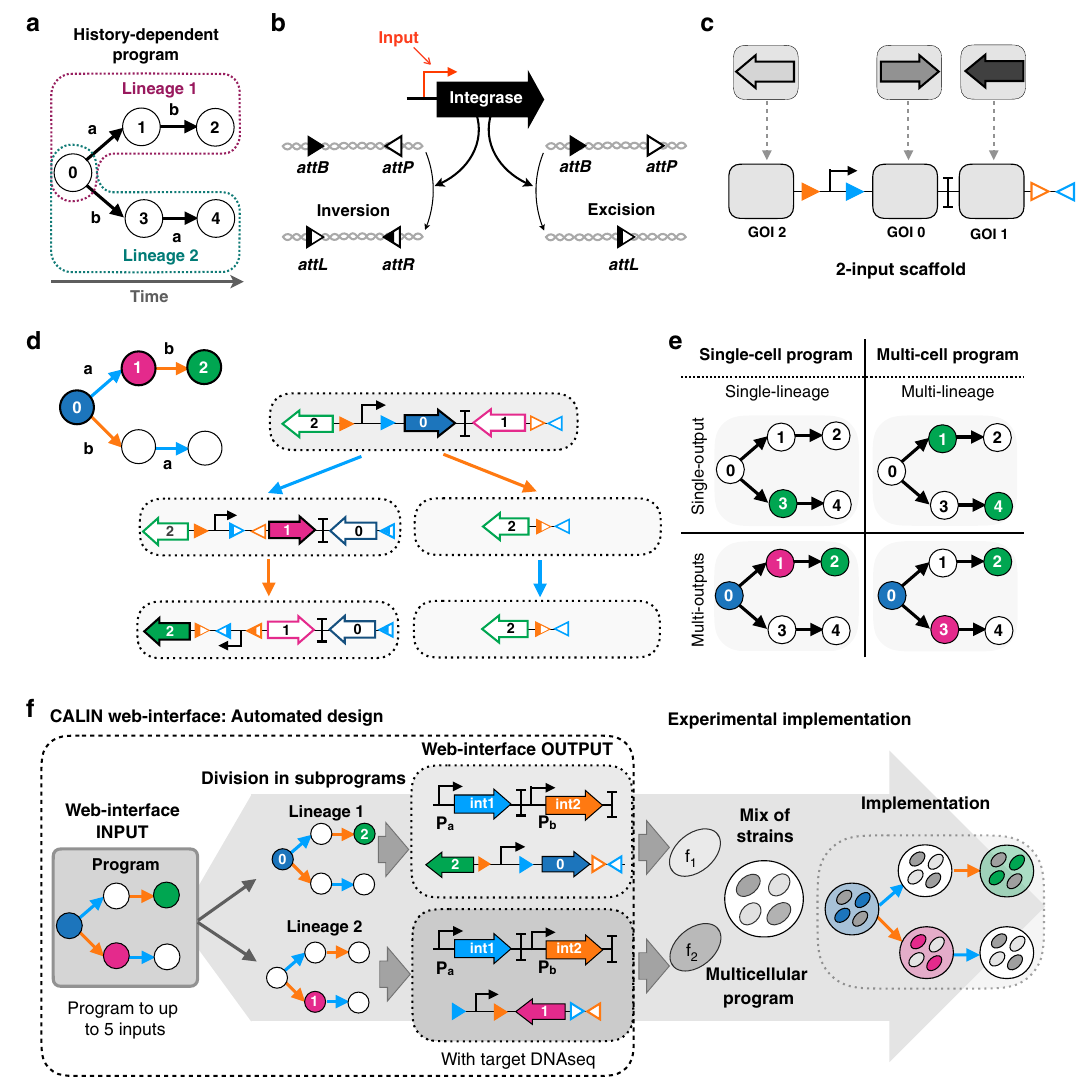
Fig. 1 Design of a modular scaffold for 2-input history-dependent multicellular programs. a Lineage tree representing a history-dependent program. Letters represent the presence of the two inputs (a and b) and numbers on nodes represent states of the system associated with the order of occurrence of the inputs. For two inputs programs, fi ve states are possible. b Integrase-mediated excision or inversion. When integrase sites are in the opposite orientation (left panel), the DNA sequence fl anked by the sites is inverted. If integrase sites are in the same orientation (right panel), the DNA sequence fl anked by the sites is excised. c 2-input history-dependent scaffold. Integrase sites are positioned to trigger expression of an output gene (arrows) or not (empty gray squares) in the corresponding lineage. Programs are implemented by inserting genes corresponding to the ON states in adequate scaffold positions. d DNA transitions, recombination intermediates, and gene-expression states for the 2-input scaffold. The corresponding lineage tree is represented in the upper left. e Single-cell programs operate in a single lineage and can control expression of single or multiple outputs. Multicell programs operate in multiple lineages and can control the expression of a single or multiple outputs. f Automated design of history-dependent programs. The CALIN algorithm takes as input a history-dependent program written as a lineage tree. CALIN decomposes multilineage programs into subprograms, each corresponding to a different lineage (a then b; b then a). For each subprogram, the algorithm identi fi es the ON states and the order of inputs within the lineage. Based on this information, the biological design is computed, and the software provides input/integrases connections, the architecture of history- dependent scaffolds and their corresponding DNA sequences. Each subprogram is executed in a different strain as a DNA device ( f 1 , f 2 ). The full program is implemented by composing the different strains into multicellular plasmid 28 in which Bxb1 integrase is under the control of the pTet promoter responding to anhydrotetracycline (aTc, input a) and Tp901-1 integrase is under the control of the pBAD promoter responding to arabinose (Ara, input b) (Fig. 2b). For programs expressing GFP in multiple output states, we used different GFP variants: sfGFP, GFP226, and GFP221. Each of